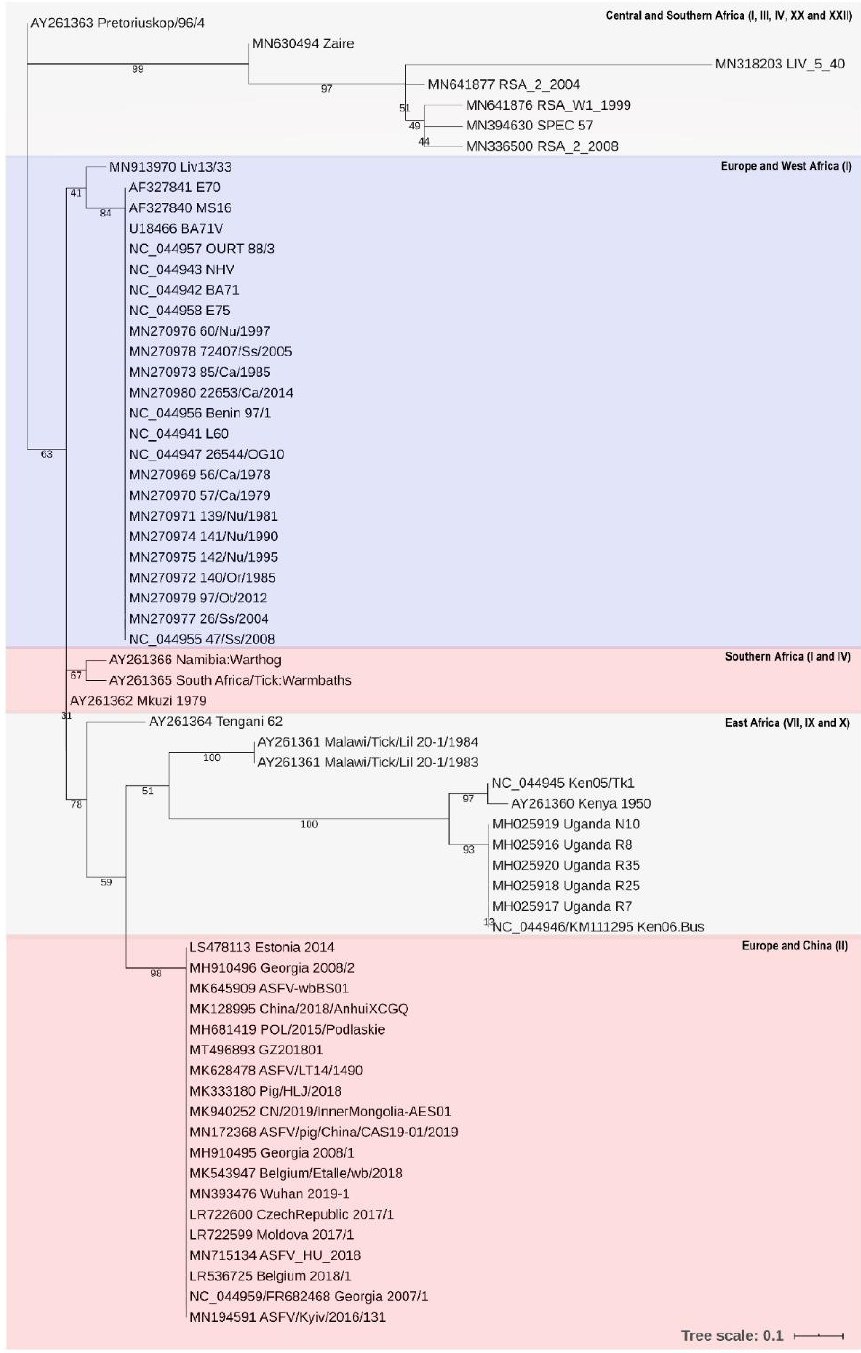
Figure 3. Phylogenetic tree of 64 different ASFV isolates. Geographic distribution and p72 genotype of ASFV isolates are indicated. Nucleotide sequences were obtained from NCBI nucleotide collection database. Trees were generated by MEGA X (version 10.1.8) [75] using the Maximum Likelihood method and Tamura-Nei model [76] and iTOL (version 4) [77] from a multiple sequence alignment generated by MAFFT (version 7) online service using the default settings as described in [78]. The reliability of the tree topology was assessed using Felsenstein's bootstrap test [79], with 1000 replications. Bootstrap values are shown next to the branches. The scale bars indicate the expected number of amino acid substitutions per site. Accession numbers are indicated in the labels.